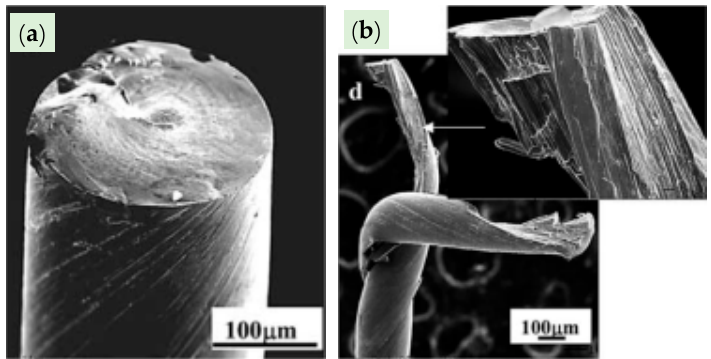
Figure 32. Delamination behavior of the wires produced at low ( a ) and high ( b ) wet drawing speeds under torsional loading. Reprinted with permission from ref. [82].